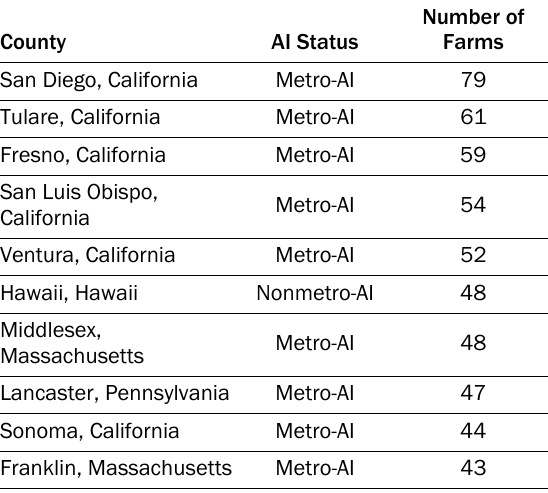
Table 10. Top 10 Counties with CSA Farms, 2007 Table 11. Top 10 Counties with